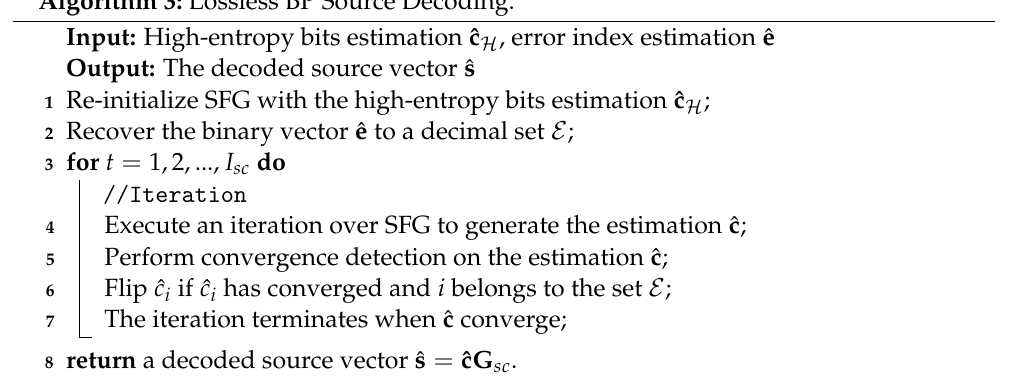
Algorithm 3: Lossless BP Source